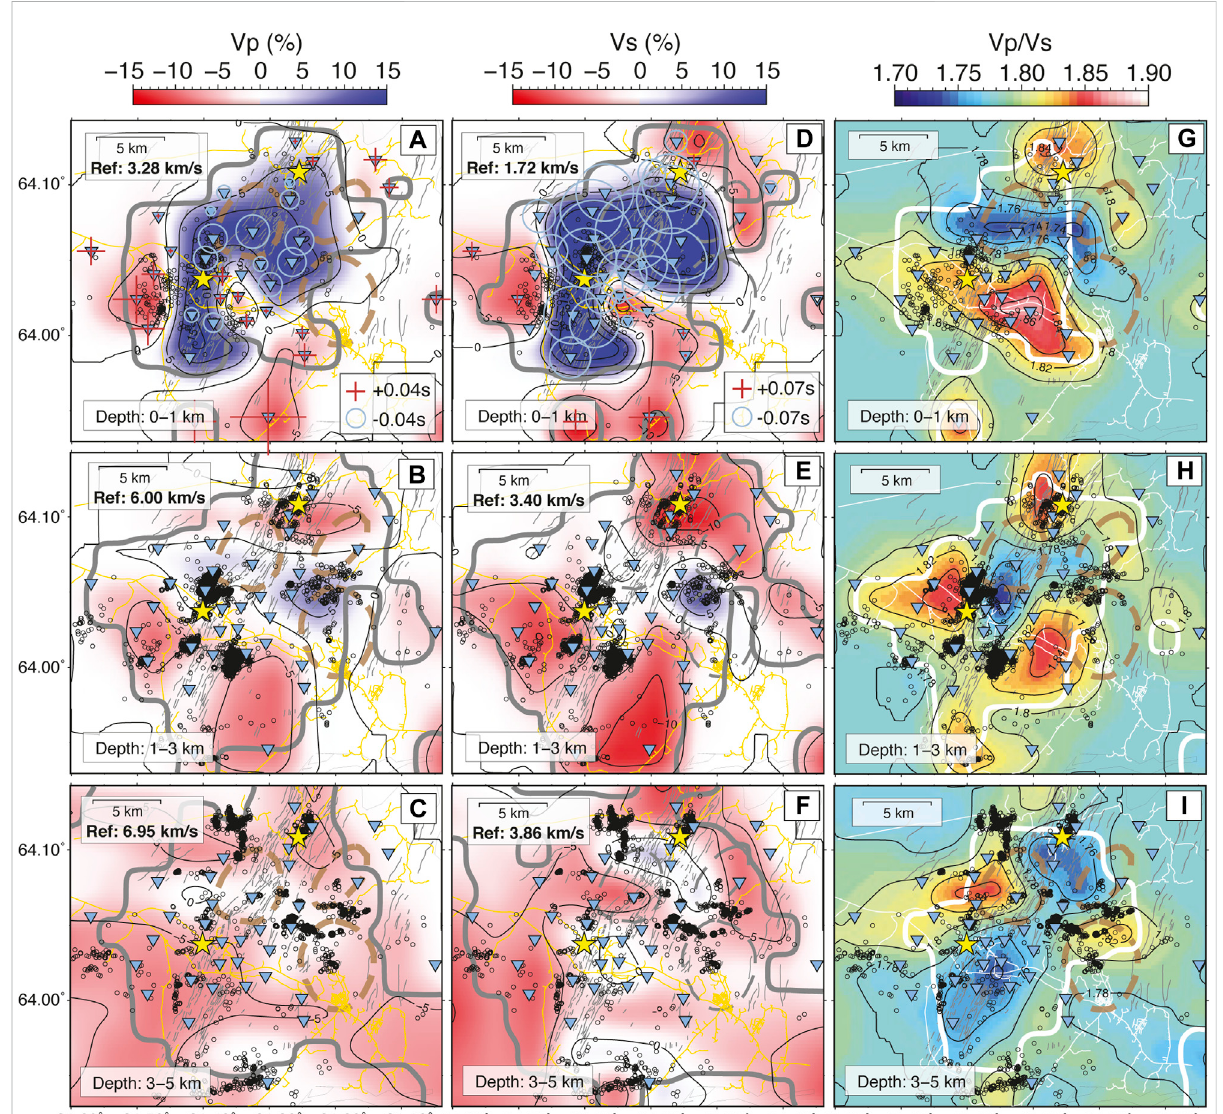
FIGURE 5 Horizontal cross-sections oftheVp (A – C) ,Vs (D, – F) andVp/Vs (G – I) velocity modelsat0, 2and 4 kmdepth presented as relativechange (in %) with respect to reference 1-D model. The reference velocity of each layer is shown on the upper left-hand side of each fi gure. The average Vp/Vs is 1.79 in the study